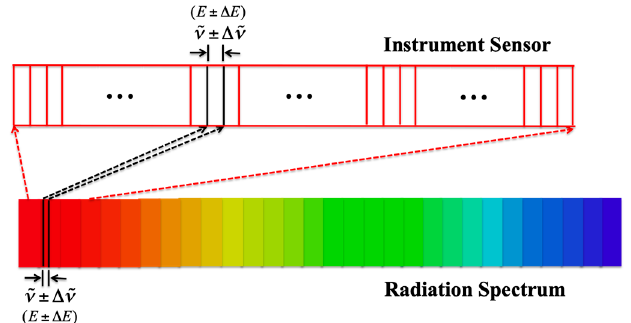
Figure 1. Detection of a portion of radiation (e.g., infrared; lower part) by an instrument sensor (upper part), where (cid:101) ν ± ∆ (cid:101) ν ( E ± ∆ E ) represents the width of wavenumber (energy) of a segment radiation (see the segment bordered by two black lines in the radiation spectrum) that is detected by the channel or band of (cid:101) ν ± ∆ (cid:101) ν ( E ± ∆ E ) in an instrument sensor (see the channel or band bordered by two black lines in the instrument sensor).